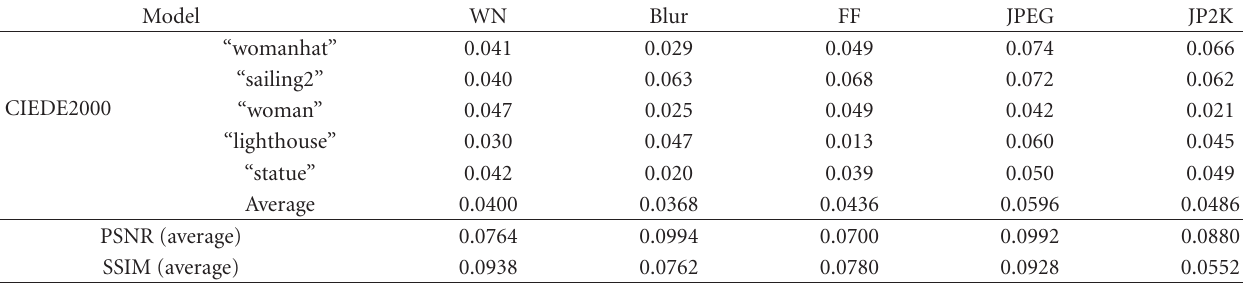
Figure 3: The linear correlation graphs from PSNR, SSIM, and DE2000-based method. (a1) to (a5), (b1) to (b5), and (c1) to (c5), respectively show the results for PSNR, SSIM, and DE2000 with five types of distortions. Table 3: MAE between algorithm and